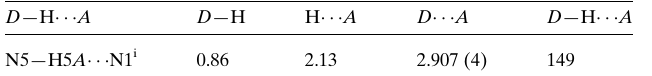
Table 1 Hydrogen-bond geometry (A˚ , (cid:3) ).